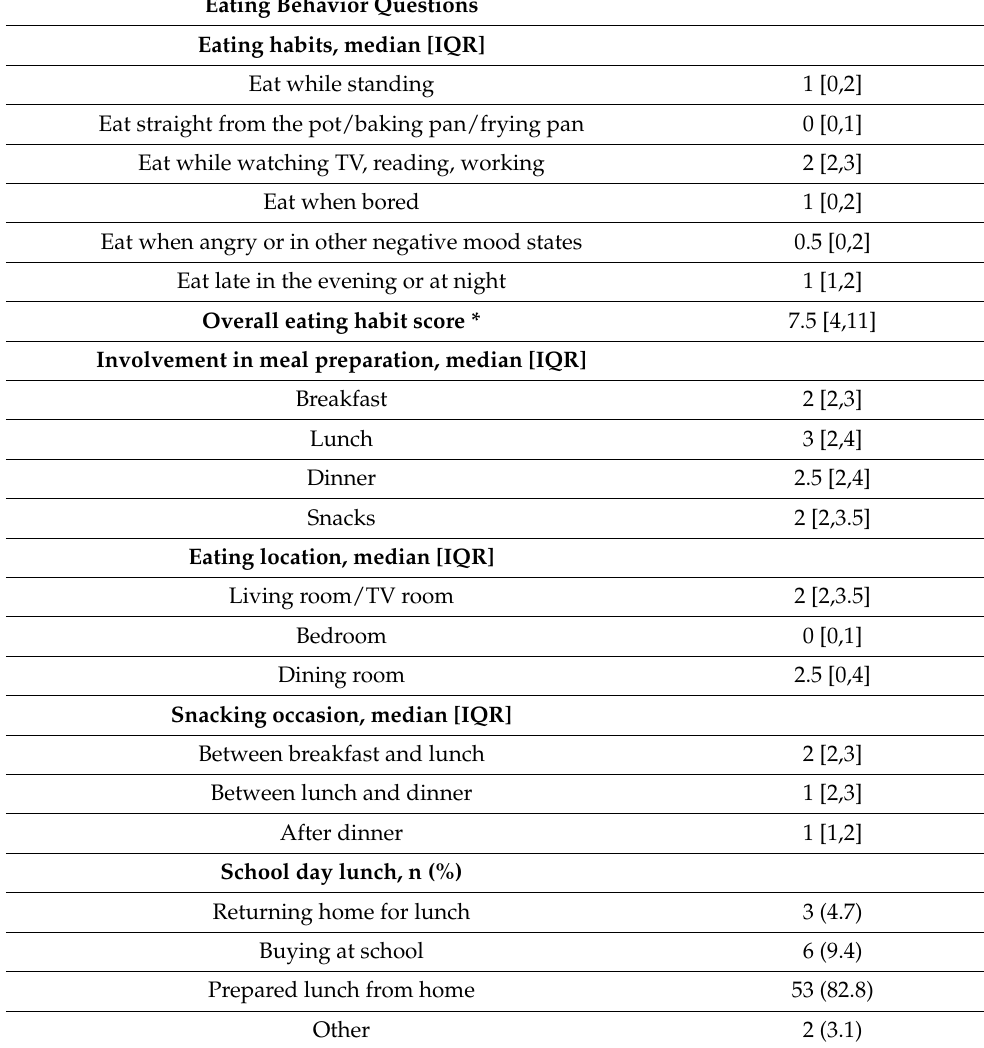
Table 3. Summary of the eating behavior